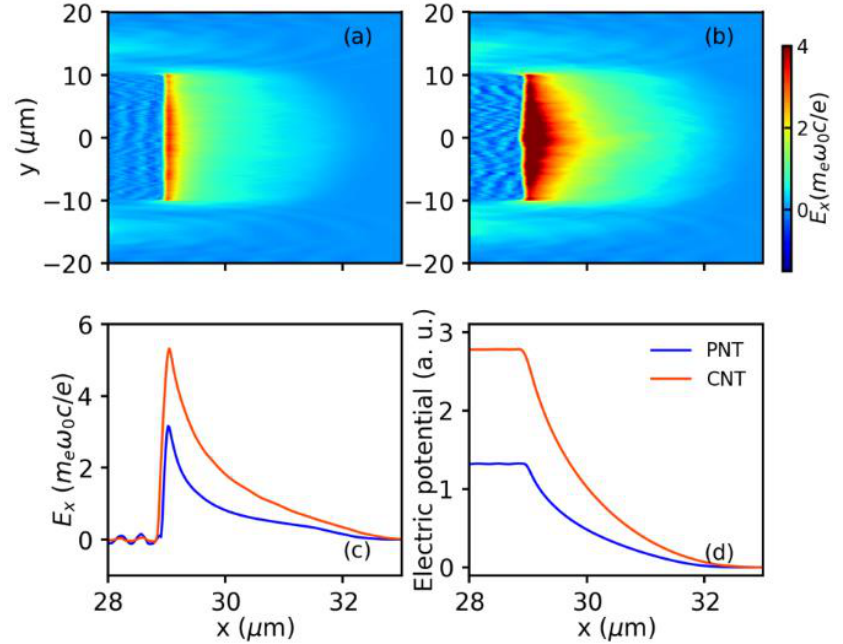
Figure 3. Longitudinal electric field ( E x ) at t = 35 T 0 near the target rear surface for the PNT ( a ) and the CNT ( b ). ( c ) Averaged E x near the region y = 0 for both targets. The electric field is normalized by m e ω 0 c / e . ( d ) Corresponding electric potential created by the sheath field near the region y = 0 for both targets.